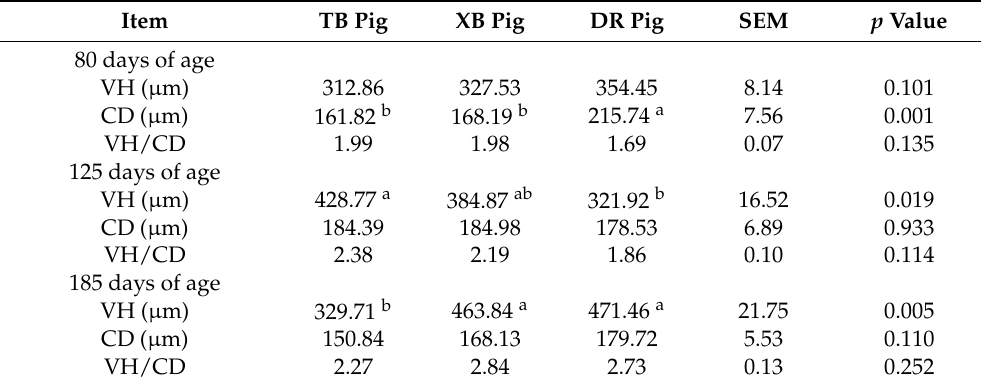
Table 9. Ileal morphology of three pig breeds at different